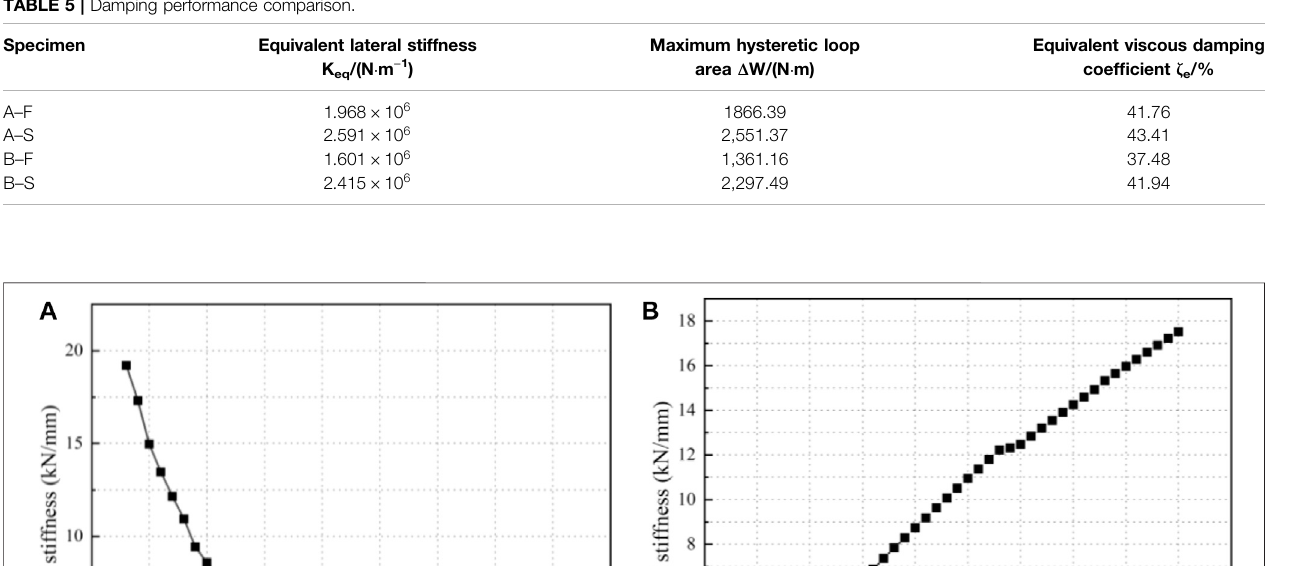
Frontiers in Materials |